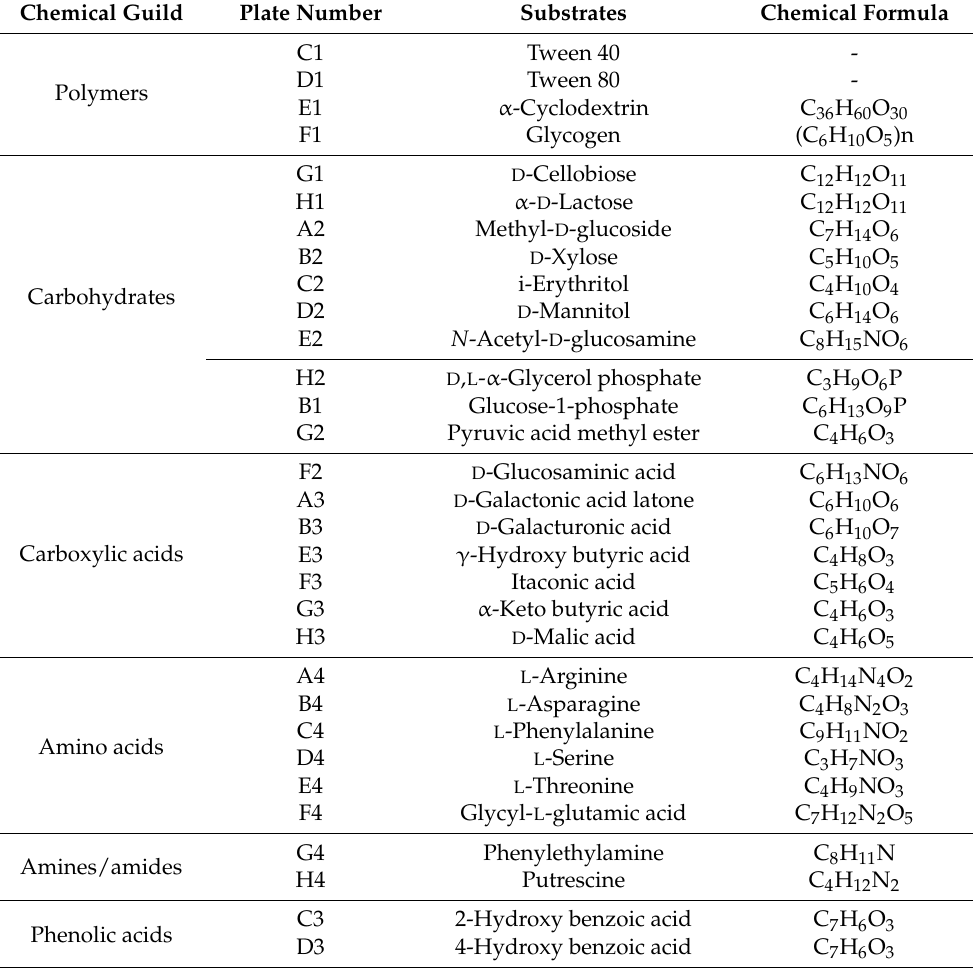
Table 2. The 31 kinds of carbon substrates in BIOLOG ECO microplates.